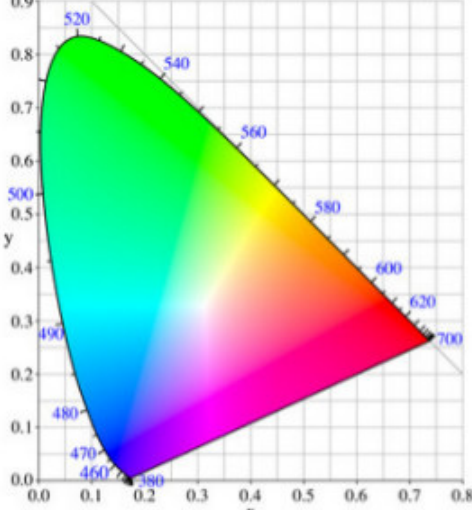
Figure 1: The 1931 CIE chromaticity diagram. The coloured region or gamut forms a 2-D colour projection plane, or cross- section, perpendicular to the luminance axis through the whole 3-D colour-solid of normal colour